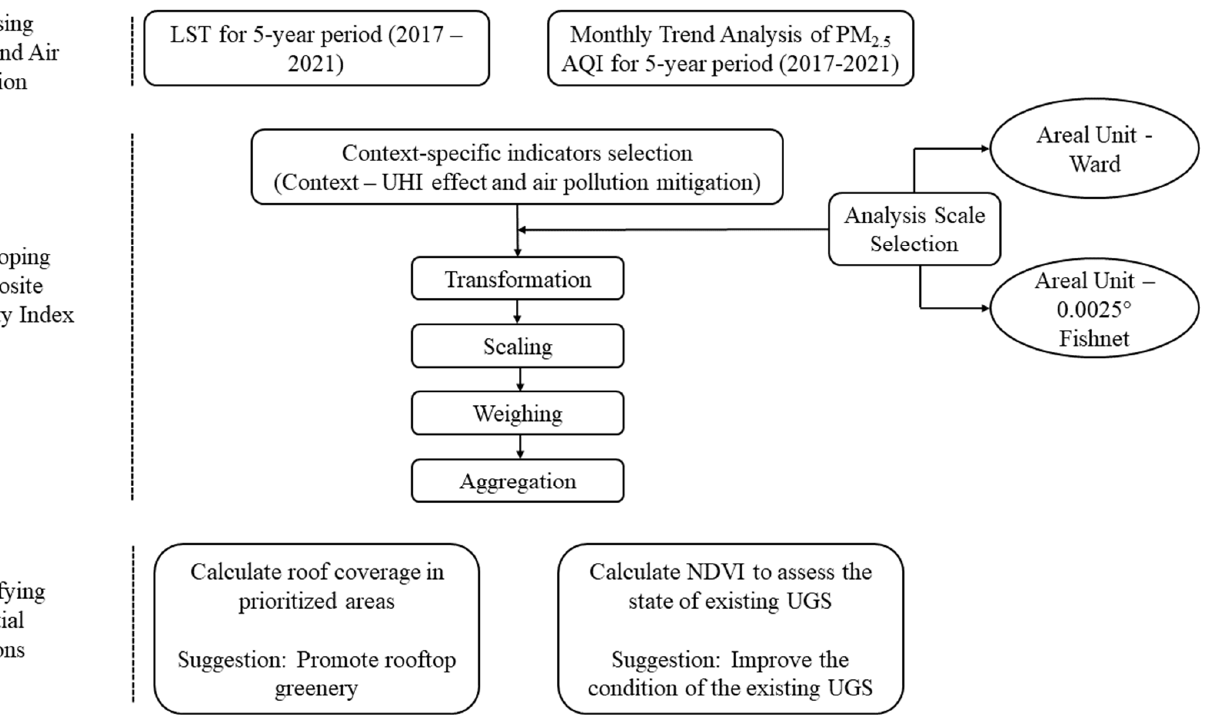
Figure 3. Flowchart of the methodology .